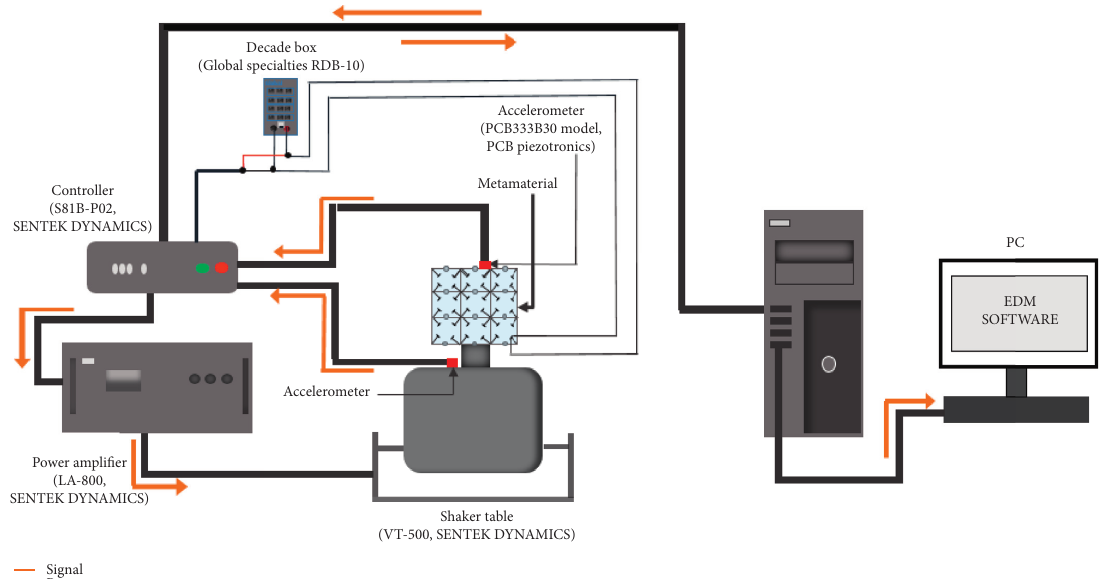
Figure 5: Cartoon schematic of the experimental apparatus used for characterization of the fabricated metamaterial vibration attenuation energy harvesting